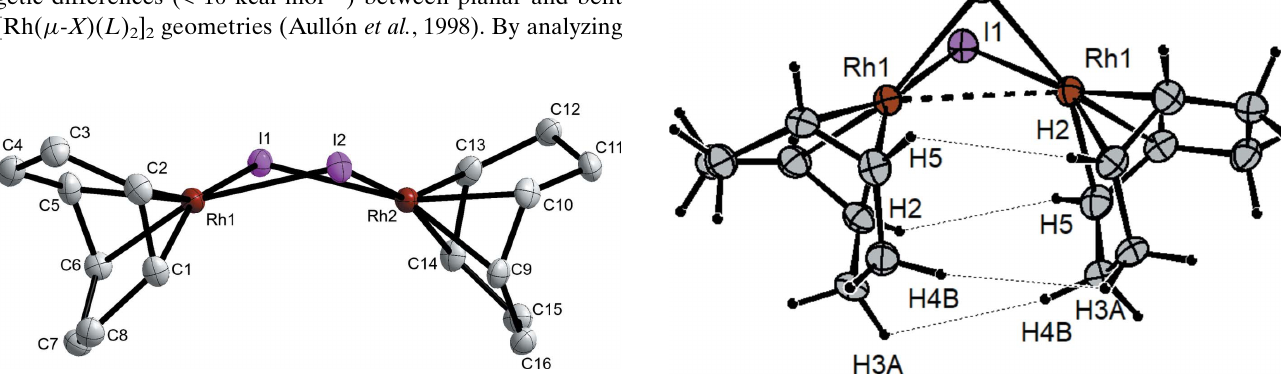
Figure 3 Diagram of [Rh( (cid:2) -I)(COD)] 2B showing weak intramolecular C— H (cid:3)(cid:3)(cid:3) H—C dispersion interactions between the two COD molecules on the two Rh centers.